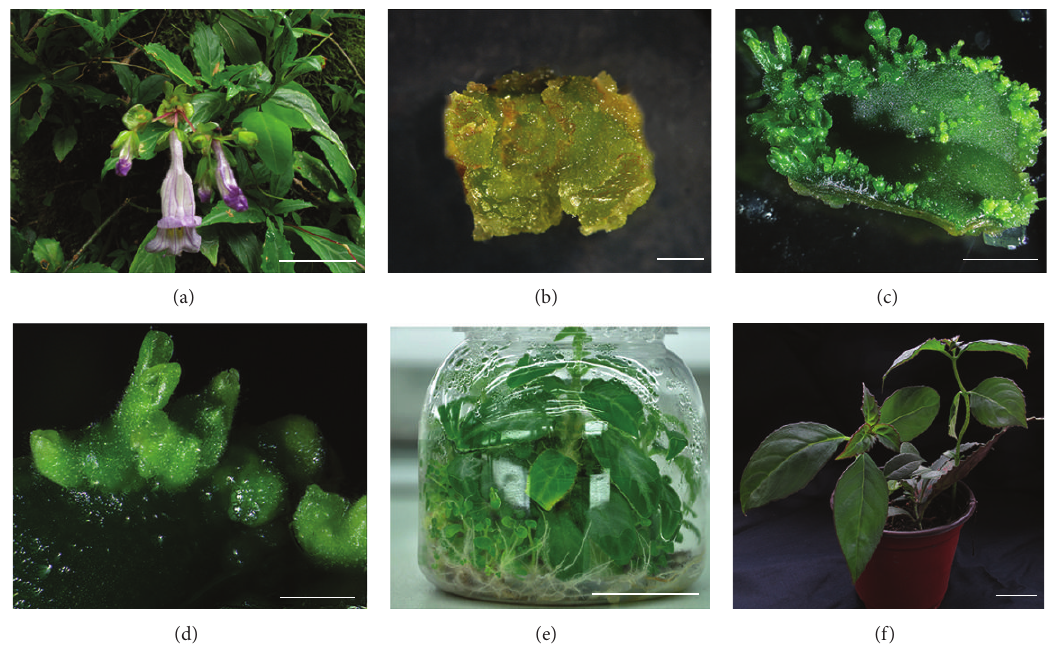
Figure 1: Morphogenesis of Lysionotus serratus . (a) Wild plant used for tissue culture, bar = 2 cm. (b) Calli appeared at the cut edge of a leaf explant on medium containing 0.5mg L −1 KIN, bar = 2 mm. (c) Adventitious shoot induced from leaf explant culture on the induction medium containing 0.5 mgL −1 BA after 25 days, bar = 2 mm. (d) High magnification of induced adventitious shoots. bar = 1 mm. (e) Plantlet with well-established root system obtained by culturing leaf explant derived shoots on medium containing 0.5 mgL −1 IBA for 45 days, bar = 2 cm. (f) Regenerated plants 5 months after transplanting grew vigorously in a shaded greenhouse, bar = 2